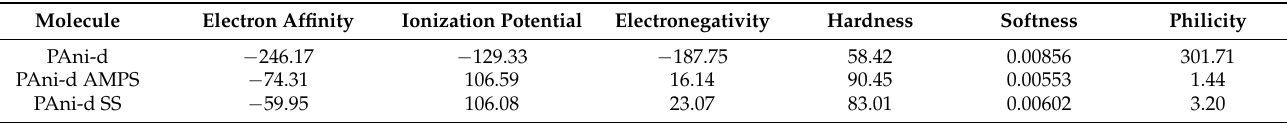
Table 2. Global descriptors of polyaniline dimers (PAni-d), kcal/mol.